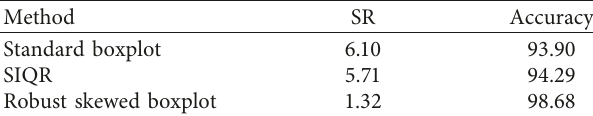
Table 2: Performance of the three boxplots without outliers.